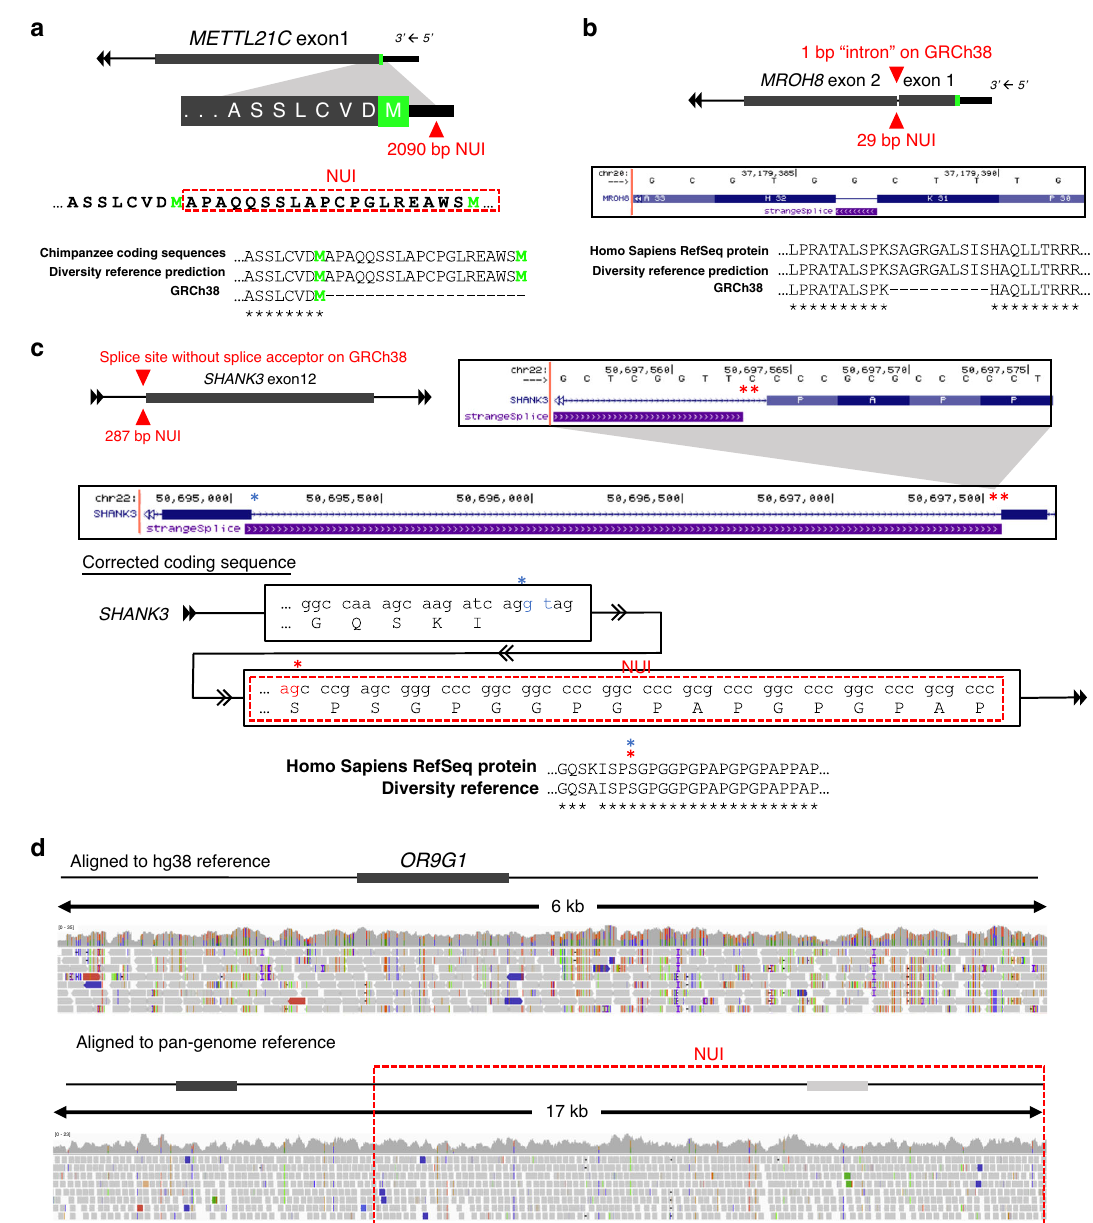
Fig. 3 Examples of NUIs affecting exonic annotations. a A 2090 bp insertion was identi fi ed 4 bp upstream of the annotated start codon based on GRCh38 annotation. Upon integrating the NUI, the open reading frame is extended by 20 amino acids with a new methionine that could now be served as the start codon. Identical coding sequences were identi fi ed in the chimpanzee RefSeq protein database. Neon green denotes the annotated and the new start